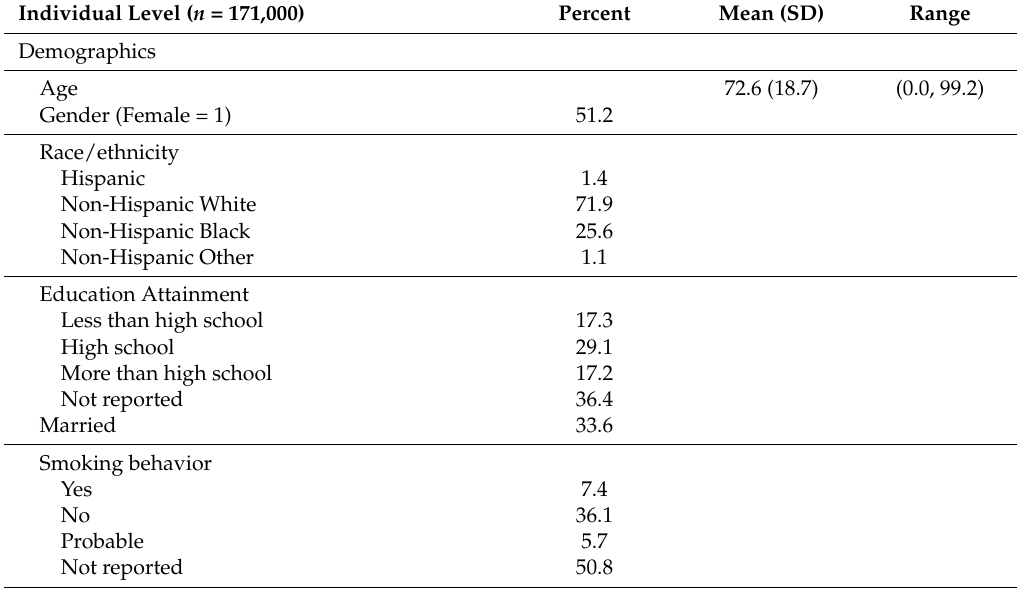
Table 1. Descriptive statistics for individual and census tract level indicators, Detroit metropolitan